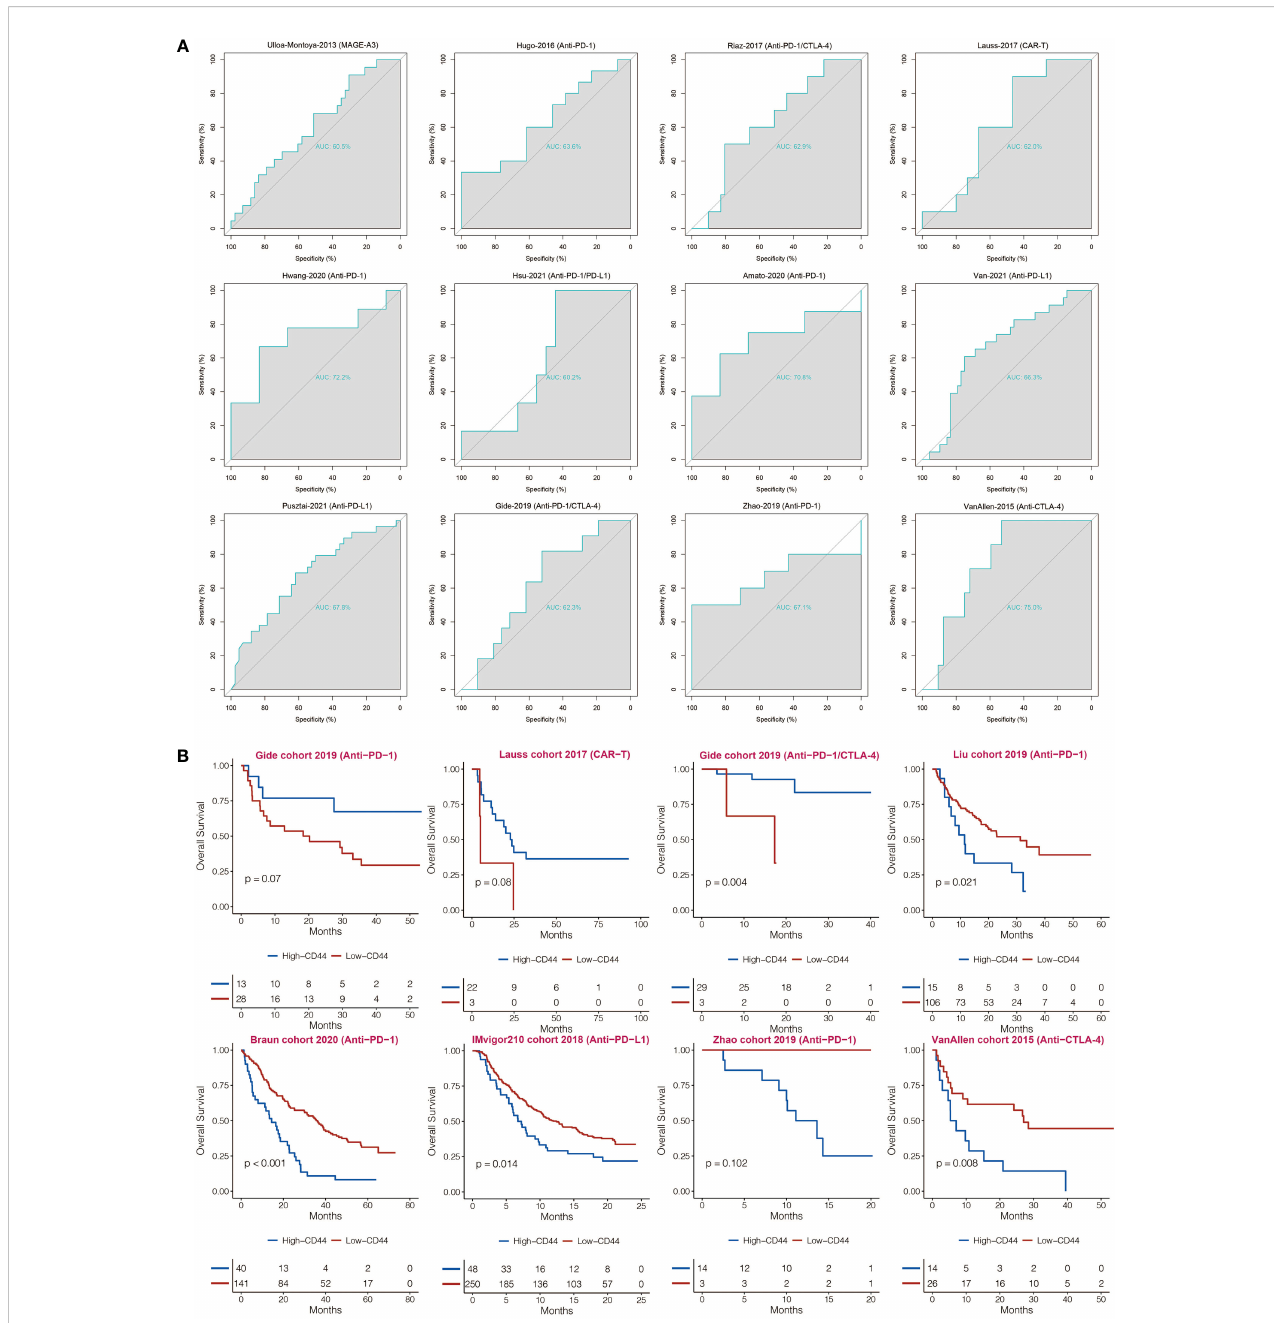
FIGURE 7 Immunotherapy prediction of CD44. (A) ROC curves regarding CD44 in immunotherapy cohorts. (B) Kaplan-Meier analysis of OS based on high vs. low expression of CD44 in immunotherapy